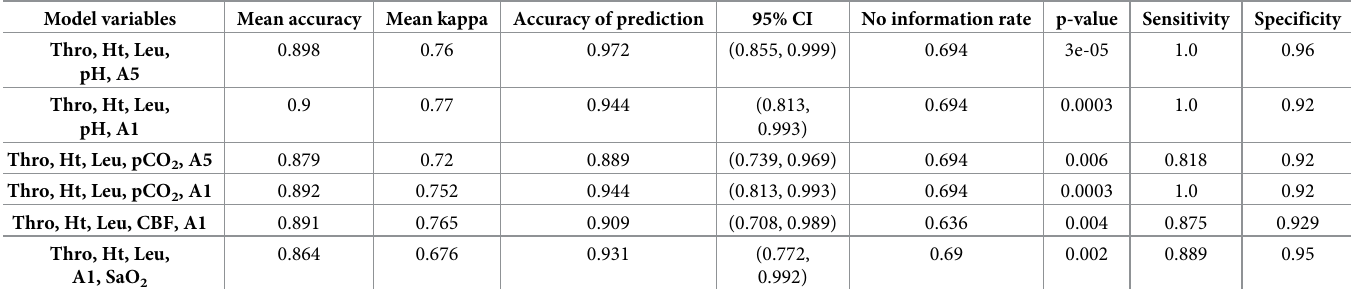
Table 7. Performance results for very preterm newborns.